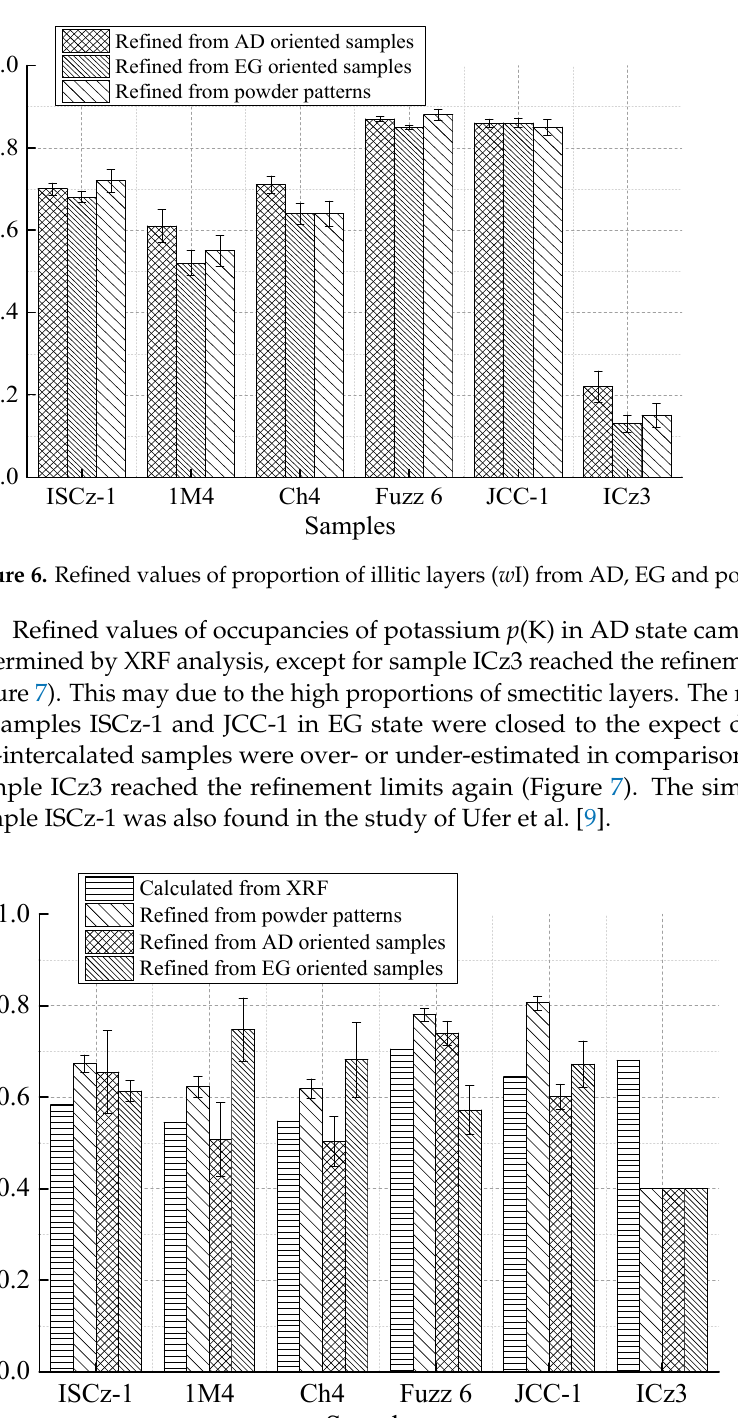
Figure 7. Refined values of occupancy of potassium p(K), compared to the values obtained by the XRF analysis.